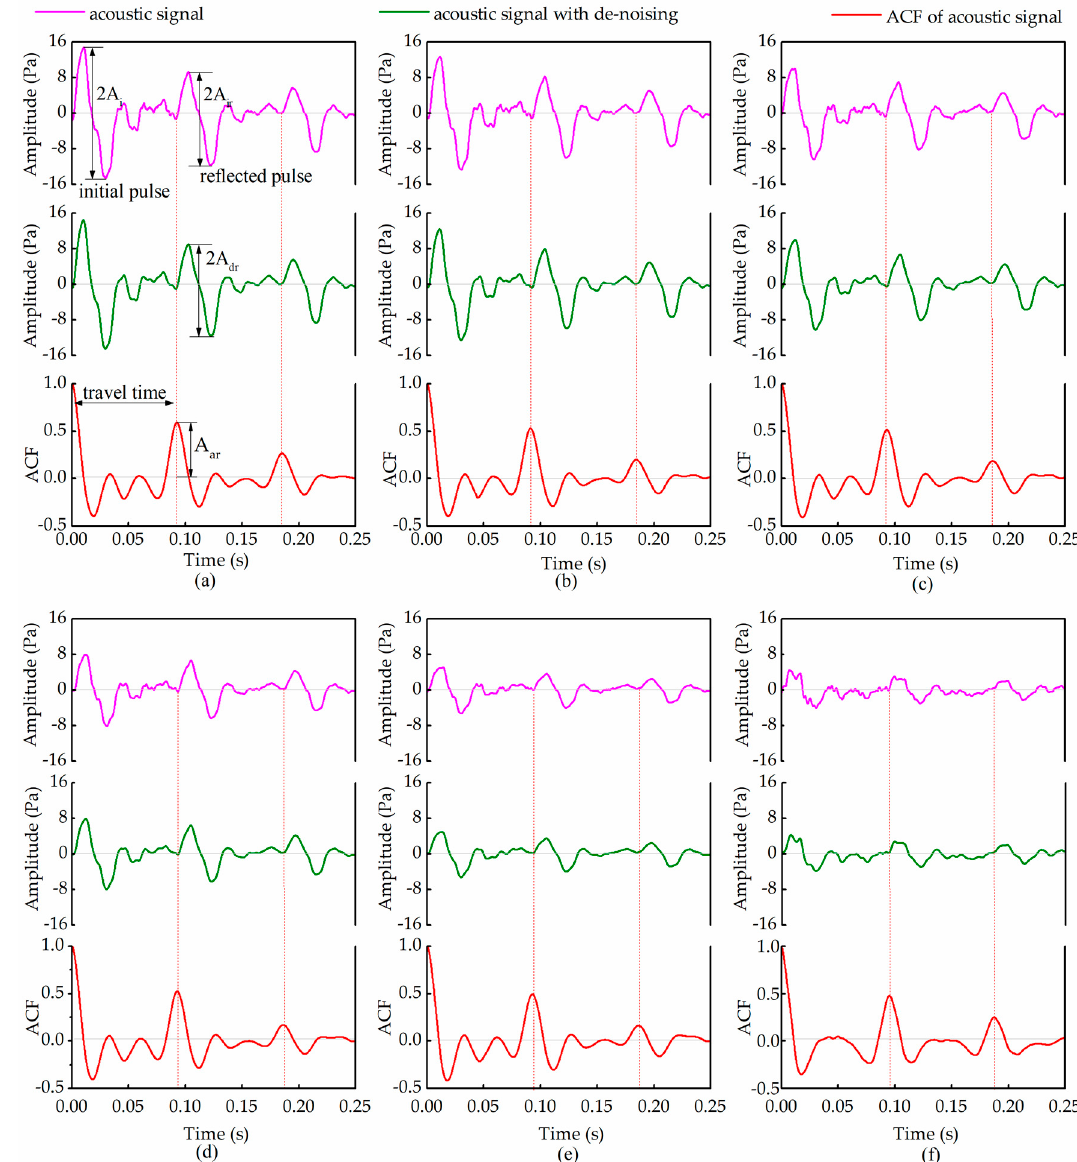
Figure 10. Performance comparison for FFT and ACF under different annulus pressures of ( a ) 2.50 MPa; ( b ) 2.00 MPa; ( c ) 1.50 MPa; ( d ) 1.00 MPa; ( e ) 0.50 MPa; ( f ) 0.05 MPa.